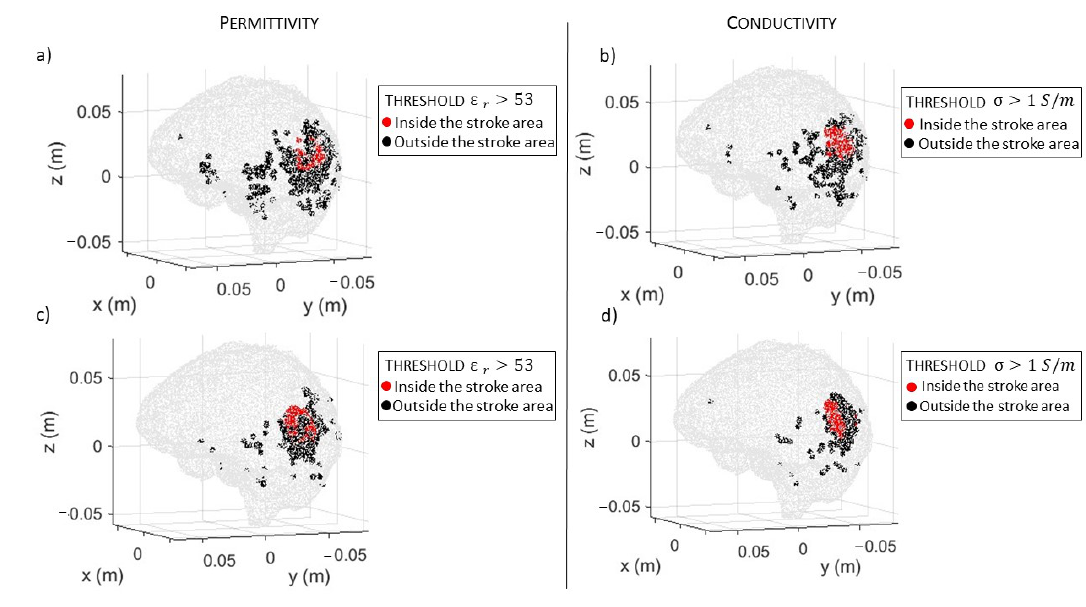
Figure 6. CSI algorithm results with the standard ( a , b ) and the proposed discretization ( c , d ). The spots correspond to the volume of the stroke identified by the algorithm after 100 iterations: permittivity ( a , c ) and conductivity ( b , d ). Red inside and black outside the stroke